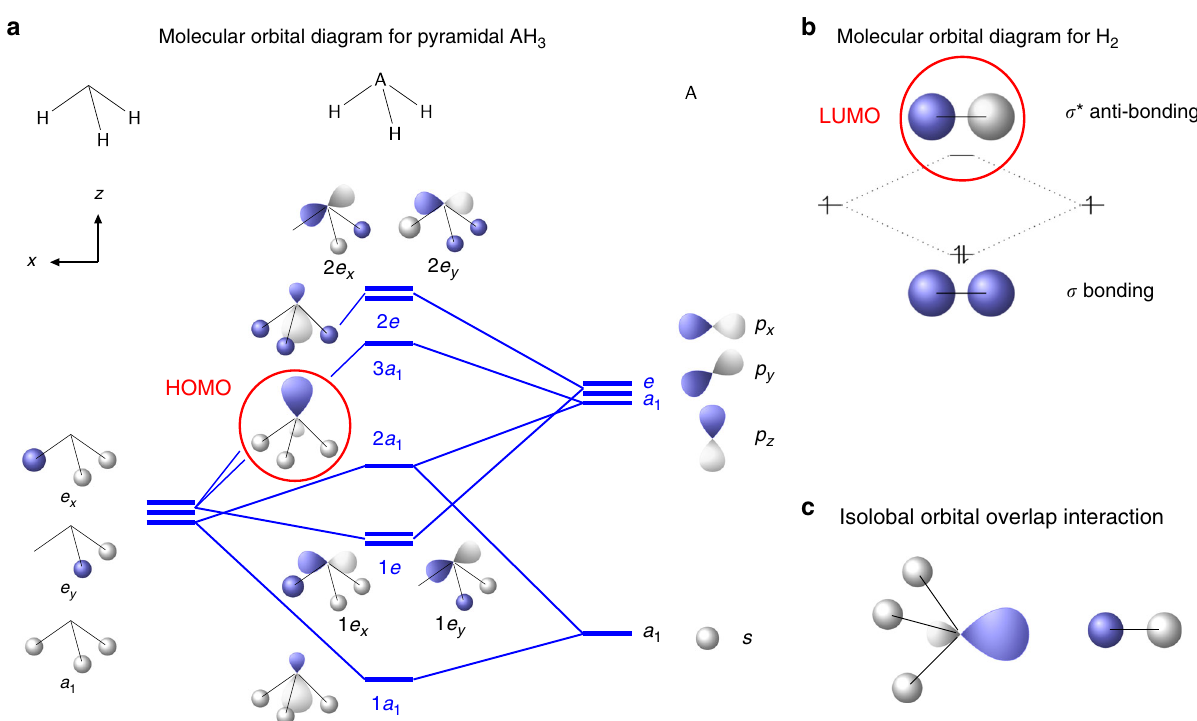
Fig. 7 The molecular orbital interaction between PH 3 and H 2 in (PH 3 ) 2 H 2 . a Qualitative molecular orbital diagram for pyramidal AH 3 (where A = N, P, Sb, Bi) obtained from the symmmetry adapted linear combination of atomic orbitals of H 3 ( C 3v ) and A fragments (adapted from Figures 4 – 9 in ref. 75 ). The orbitals of each fragment are aligned vertically, in order of increasing energy from bottom to top, under the corresponding column of panel a, with H 3 on the left side, AH 3 in the middle and A on the right side. The 2 a 1 highest occupied molecular orbital (HOMO), where the electron lone pair is located, is highlighted by a red circle. b Molecular orbital diagram for H 2 , showing the completely fi lled σ bonding molecular orbital and the empty σ * anti-bonding lowest unoccupied molecular orbital (LUMO) highlighted by a red circle. c Isolobal orbital overlap interaction between the 2 a 1 molecular orbital of AH 3 and the σ * anti-bonding molecular orbital of H 2